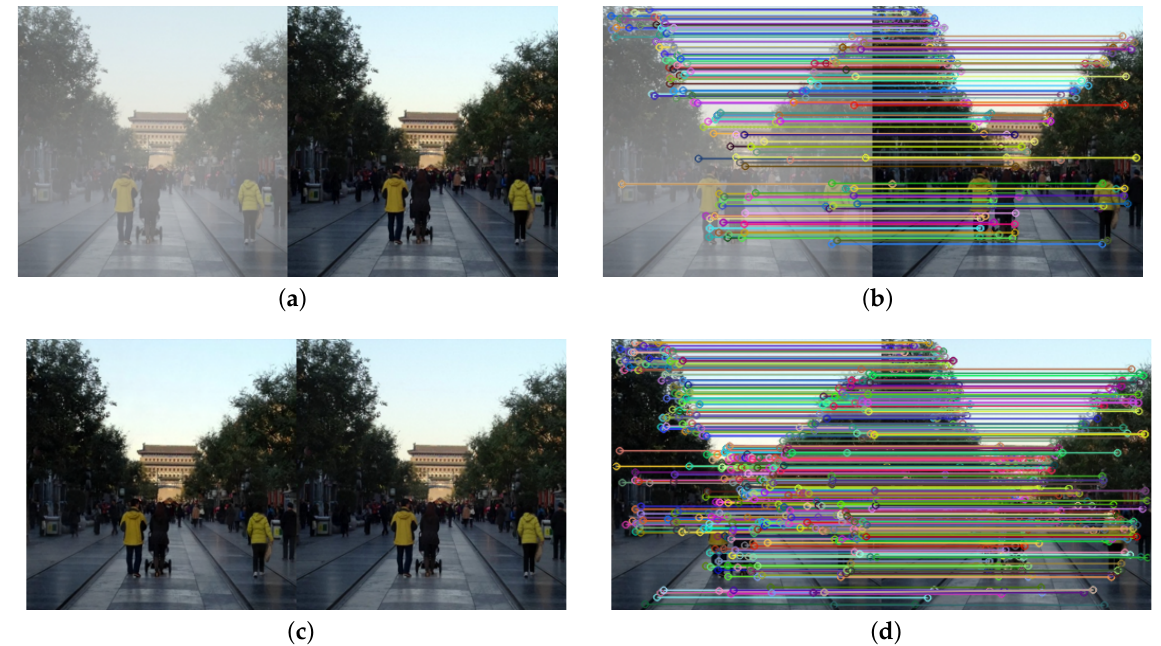
Figure 9. The schematic diagram of image registration: ( a ) the hazy and corresponding haze-free images; ( b ) image registration of ( a ); ( c ) the restored and corresponding haze-free images; ( d ) image registration of ( c